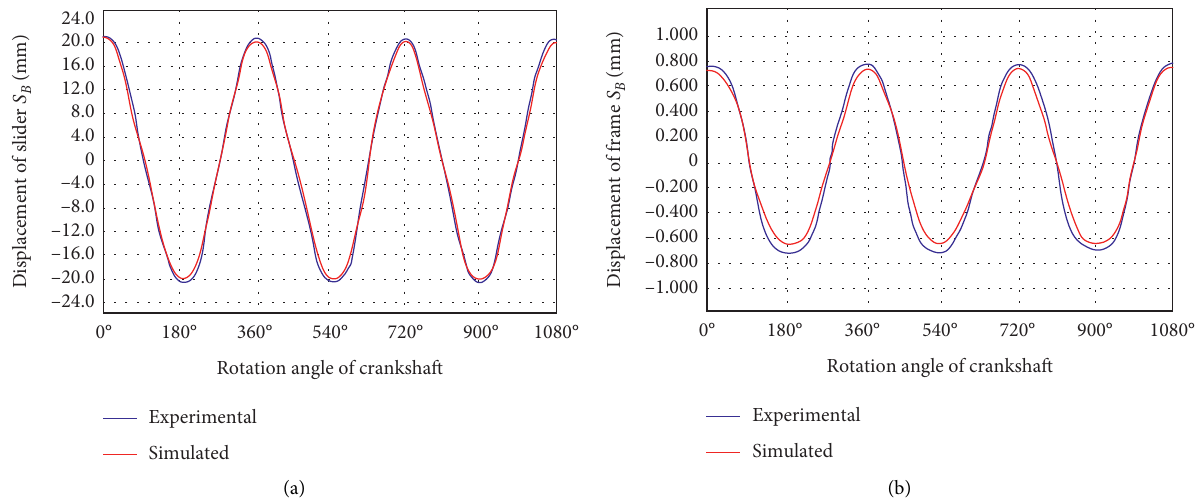
Figure 9: Experimental and simulated displacement curves of slider and frame under the motor speed of 1200rpm: (a) displacement curve of slider; (b) displacement curve of